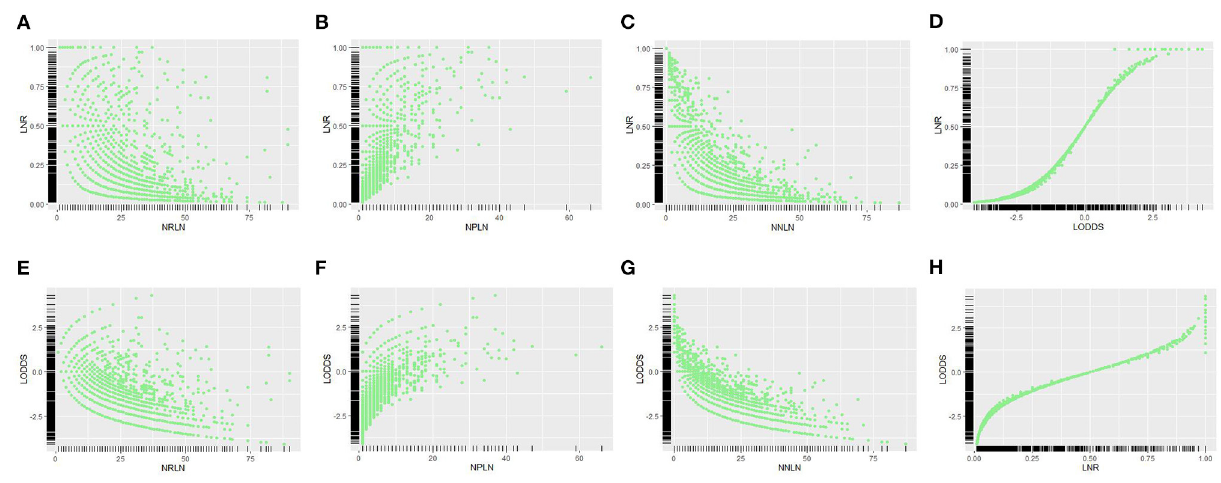
FIGURE 2 | Scatter plots of the relationship between LNR vs. (A) NRLN, (B) NPLN, (C) NNLN, and (D) LODDS. The relationship between LODDS vs. (E) NRLN, (F) NPLN, (G) NNLN, and (H) LNR was described. NRLN, number of retrieved lymph nodes; NPLN, number of positive lymph nodes; NNLN, number of negative